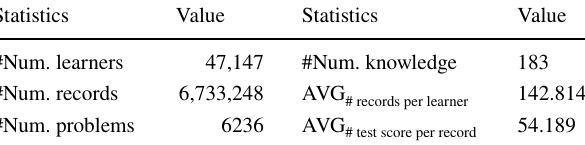
Table 3 Statistics of LUOGU OJ dataset